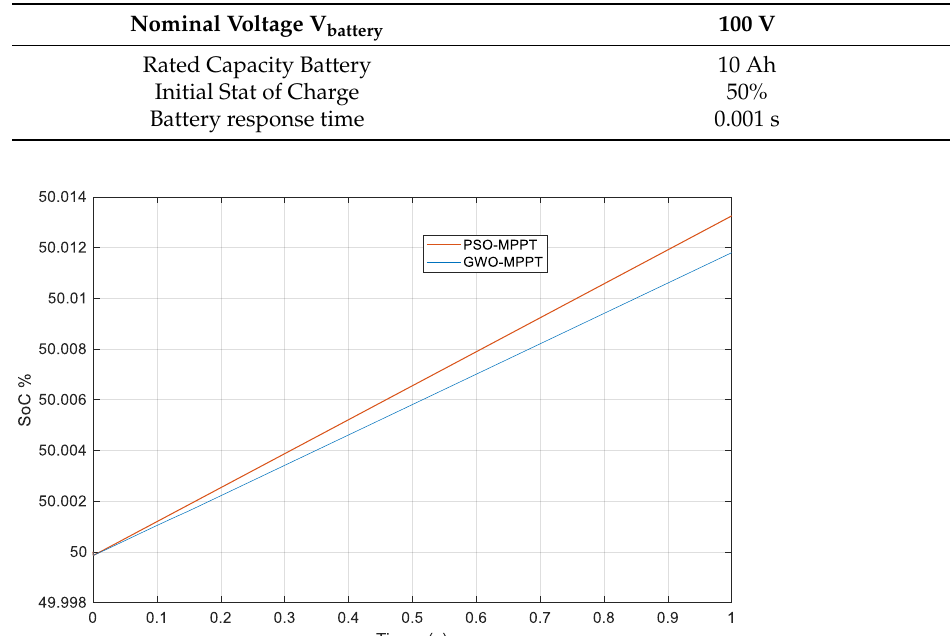
Table 6. Parameters of lithium-ion battery.